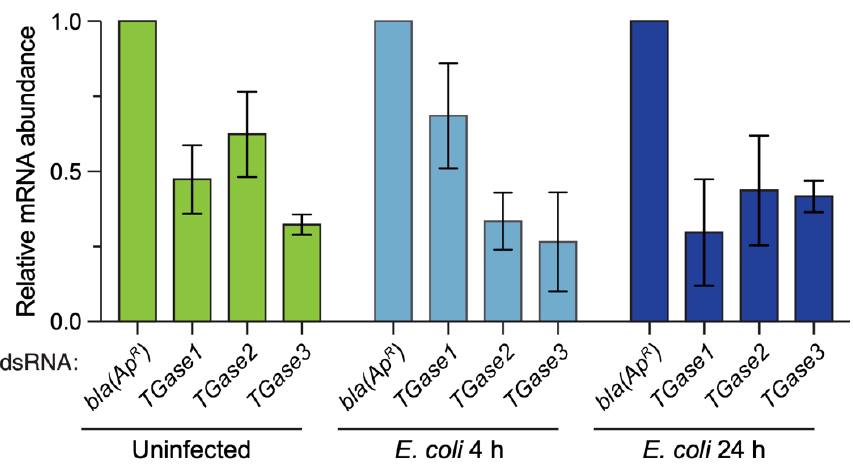
Figure 1. RNAi-based knockdown efficiency of TGase1 , TGase2 and TGase3 in uninfected and infected mosquitoes. Graphs display the relative mRNA abundance in mosquitoes treated with bla(Ap R ) , TGase1 , TGase2 or TGase3 dsRNA. Mosquitoes were uninfected or had been infected with E. coli for 4 or 24 h, and mRNA abundance was calculated relative to the bla(Ap R ) for each treatment. Column heights mark the mean, and whiskers indicate the standard error of the mean (S.E.M.).